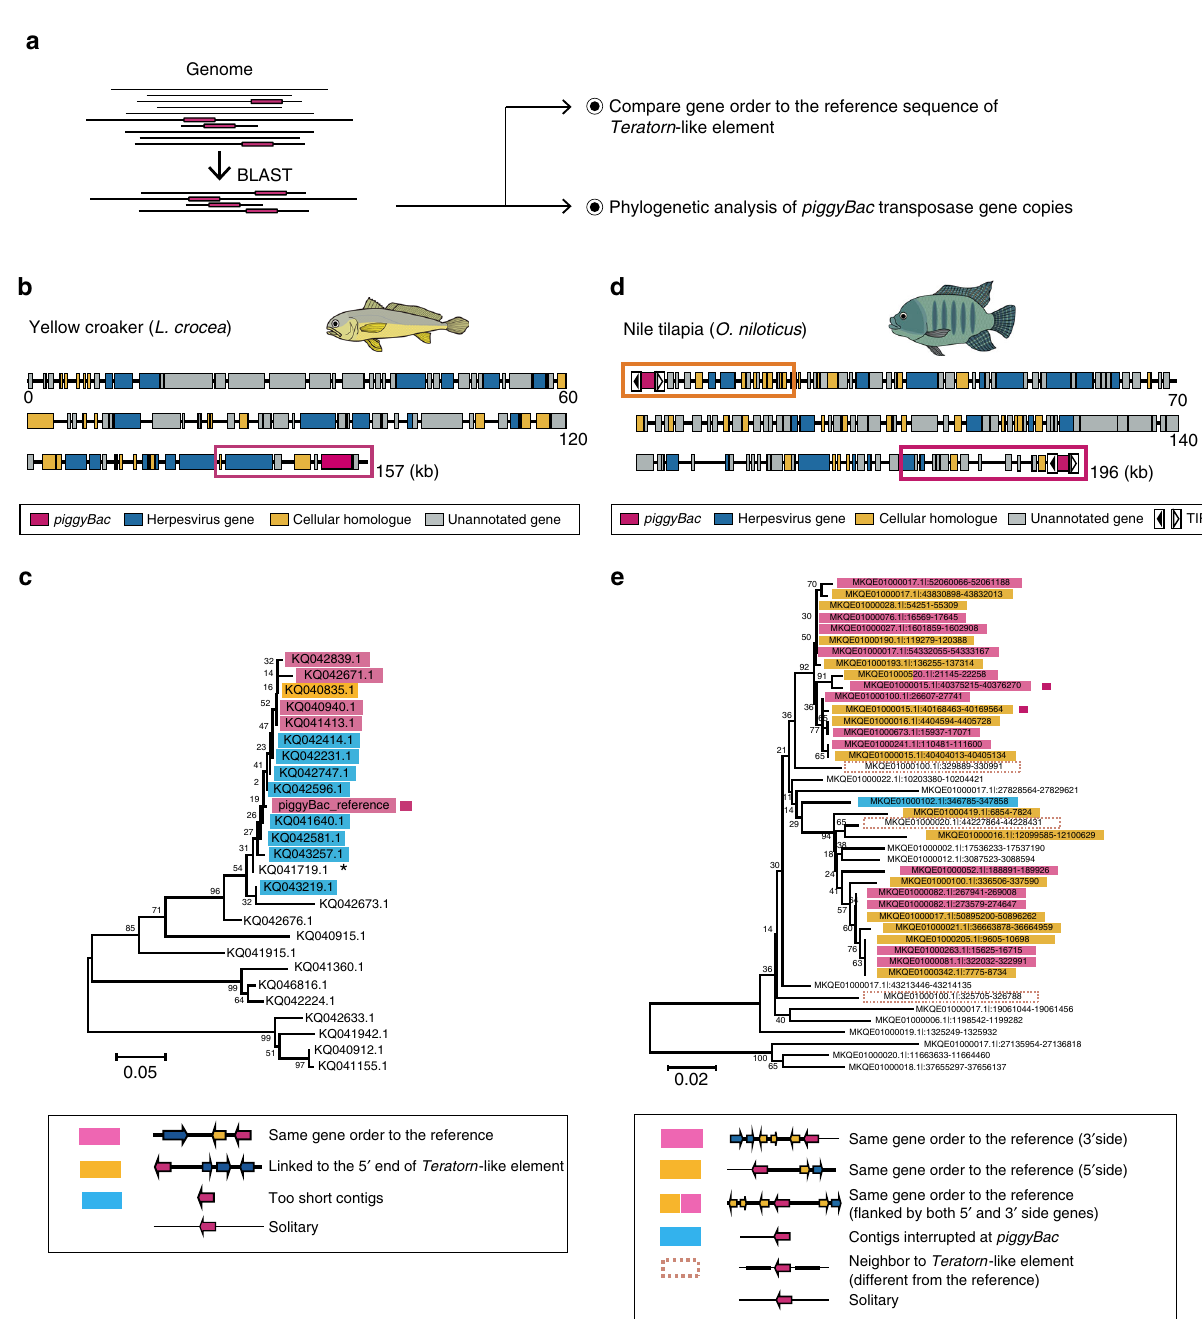
Fig. 5 piggyBac -herpesvirus fusion in other species. a The procedure of screening all scaffolds that include the piggyBac transposase gene inside Teratorn - like element in yellow croaker ( Larimichthys crocea ) and nile tilapia ( Oreochromis niloticus ). First, contigs that contain the transposase gene were screened from the genome by blastn. For all contigs obtained, genomic neighborhoods around the transposase genes were tested by displaying alignment with the reference sequence of Teratorn -like element. In parallel, the phylogenetic relationship of the transposase copies was analyzed. b Reference sequence of Teratorn -like elements of yellow croaker. Predicted ORFs (exons) are depicted by colored arrows according to the categories; magenta , piggyBac transposase; blue , herpesvirus genes; yellow , cellular homologues; gray , unannotated genes. c Neighbor-joining tree based on the sequences of piggyBac transposase copies obtained by blast search is displayed. One region (1369 – 1598) of the reference transposase sequence was utilized for the phylogenetic tree construction. Each sequence is named by the contig name (e.g., KQ042839.1). piggyBac copies are categorized into four groups, according to the linkage to the herpesvirus genes. Note that piggyBac copies adjacent to the herpesvirus-like sequence ( magenta ) are clustered together, suggesting that a particluar type of piggyBac element is fused with the herpesvirus-like sequence. d Reference sequence of the Teratorn -like element of nile tilapia. e Neighbor-joining tree based on the sequences of piggyBac transposase copies obtained by blast search is displayed. piggyBac copies are categorized into six groups as described in the inset , according to the linkage to the herpesvirus-like sequence. Note that there are multiple piggyBac copies linked to the herpesvirus-like sequence in the same con fi guration as the reference sequence (either 5 ′ and 3 ′ end of Teratorn like element, yellow and magenta ), although phylogenetically polyphyletic. The scale bars in c and e represent the number of substitutions per